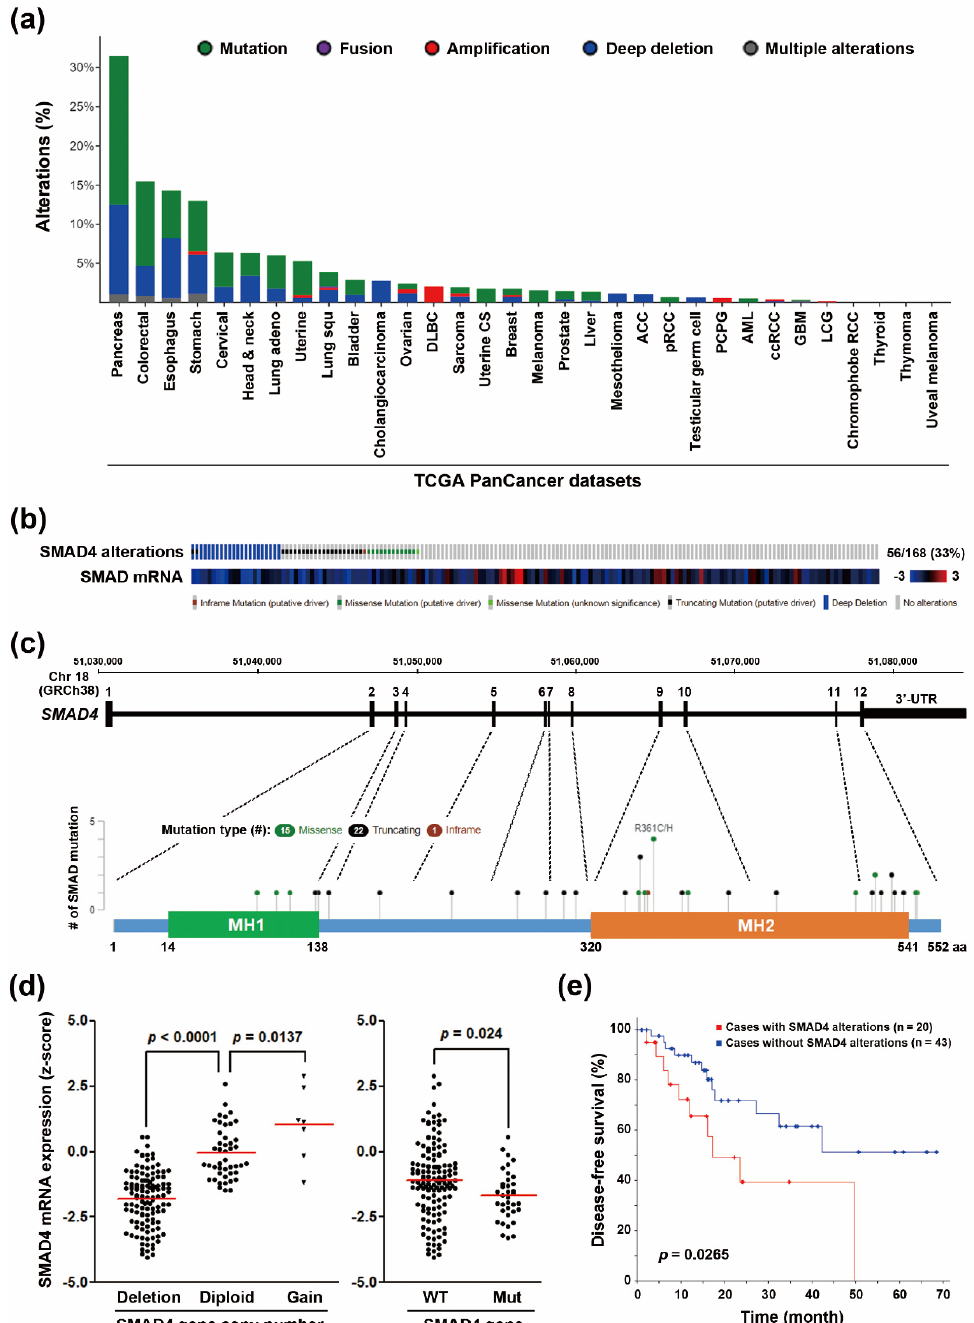
Figure 1. Copy number amplification of SMAD4 gene in pancreatic ductal adenocarcinoma (PDAC). ( a ) SMAD4 gene was analyzed for gene alterations (mutation status and copy number variation) in various cancertypesusing“TCGA,PanCancerAtlas”datainthecBioPortalcancergenomicsdatabase; ( b )Abarcode plot for the comparison of SMAD4 gene alterations and mRNA expression in PDAC; ( c ) A cartoon diagram for the gene and protein structures of SMAD4. MH1 (the Mad homology 1) region is sequence-specific DNA binding domain. MH2 region is responsible for heteromerization and transactivation. This figure was adapted from the image obtained from the cBioPortal website (http: // www.cbioportal.org / ); ( d ) A scatter plot for the comparison of SMAD4 copy number amplification and mRNA expression in PDAC. WT, wildtype. Diploid, two alleles present; Gain, low-level gene amplification event; Mut, mutation; ( e ) The impact of SMAD4 gene alterations on disease-free survival of PDAC